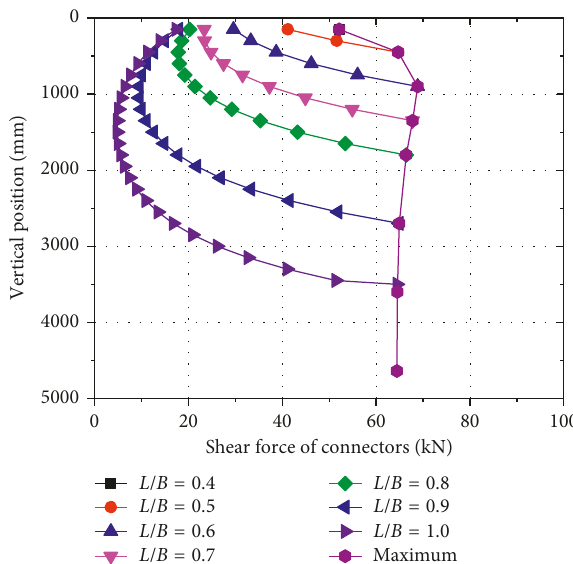
Figure 16: Effect of hybrid joint length on shear force distribution.